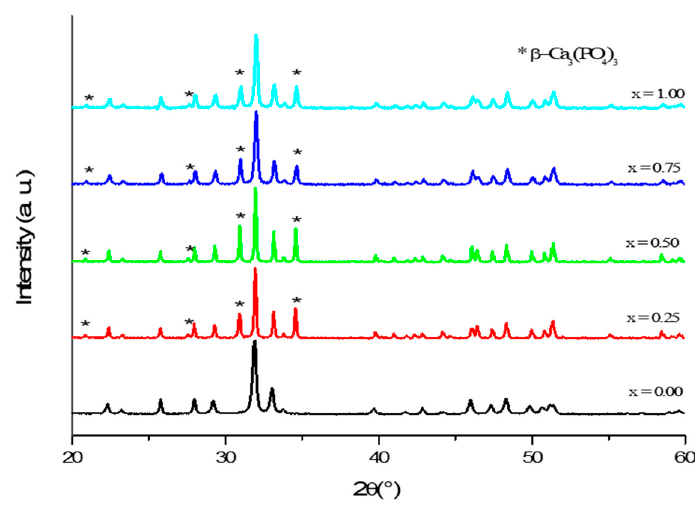
Figure 5. XRD spectra of Ca 10 − x K x (PO 4 ) 6 F (2 − 2 x ) (OH) x for 0 ≤ x ≤ 1, calcined at 1050 ◦ C.